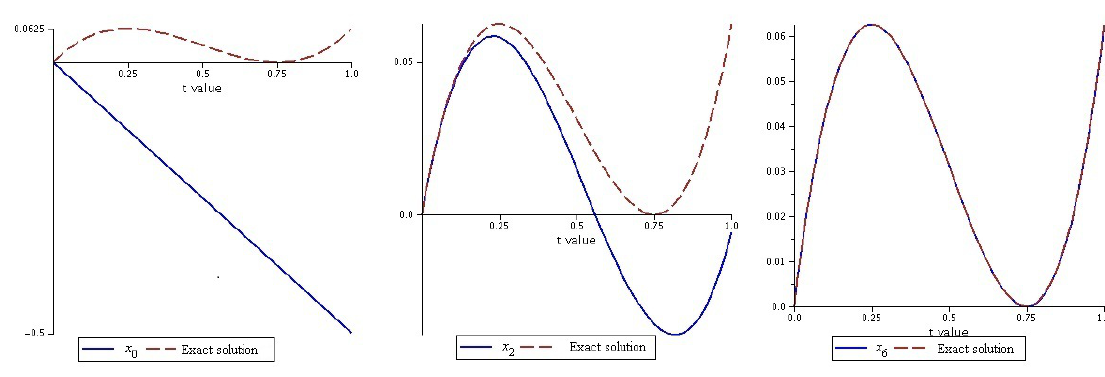
Figure 3: Graphs of x n and exact solution